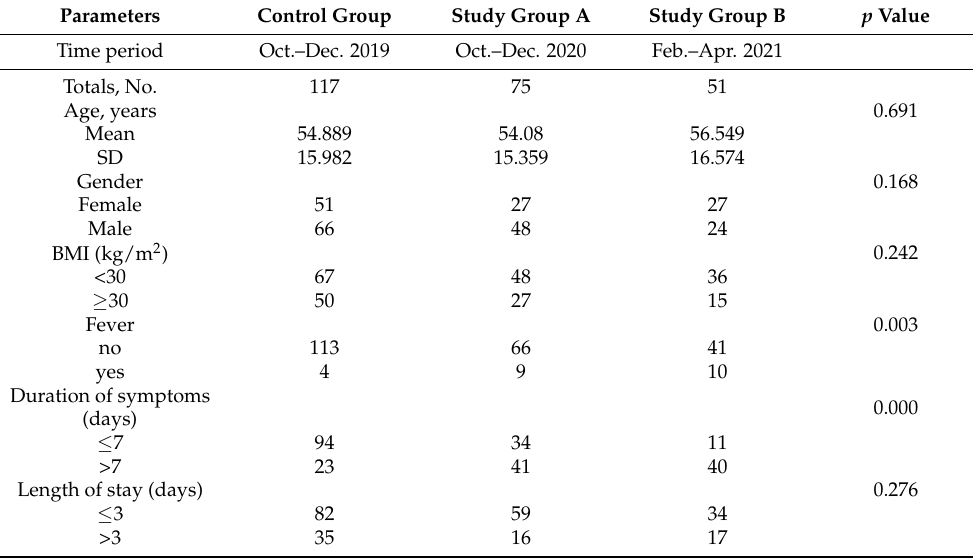
Table 1. Baseline patients’